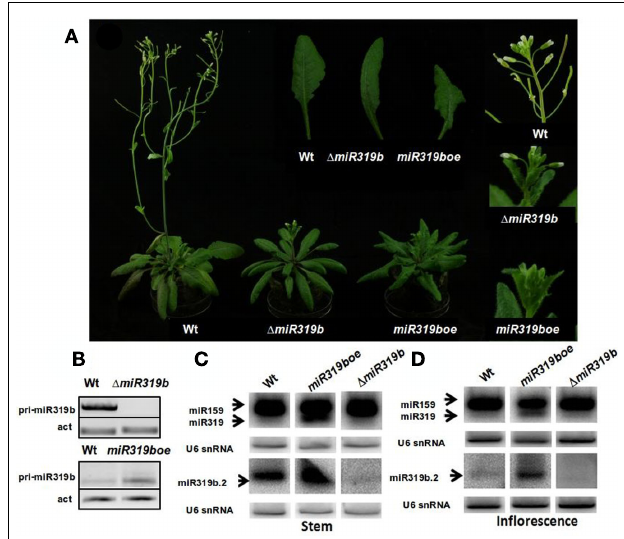
FIGURE 3 |The phenotypes of 42-day-old A. thaliana wild type, Δ miR319b (Salk_037093), and miR319boe (Salk_059451) mutant plant (A). RT-PCR profiling of the pri-miR319b level. (B) The upper panel shows the increased level of primary transcript in the miR319boe mutant and the lower panel – the lack of transcript in the case of Δ miR319b mutant plants. Northern blot hybridization (C,D) of miR319 and miR319b.2 in the wild type, miR319boe and Δ miR319b mutant plants. RNA was isolated from stems [left panel (C) ] and inflorescenses [right panel (D) ]. For better visualization of miR319b.2 hybridization signals, these blots were longer exposed than in the case of miR319b.